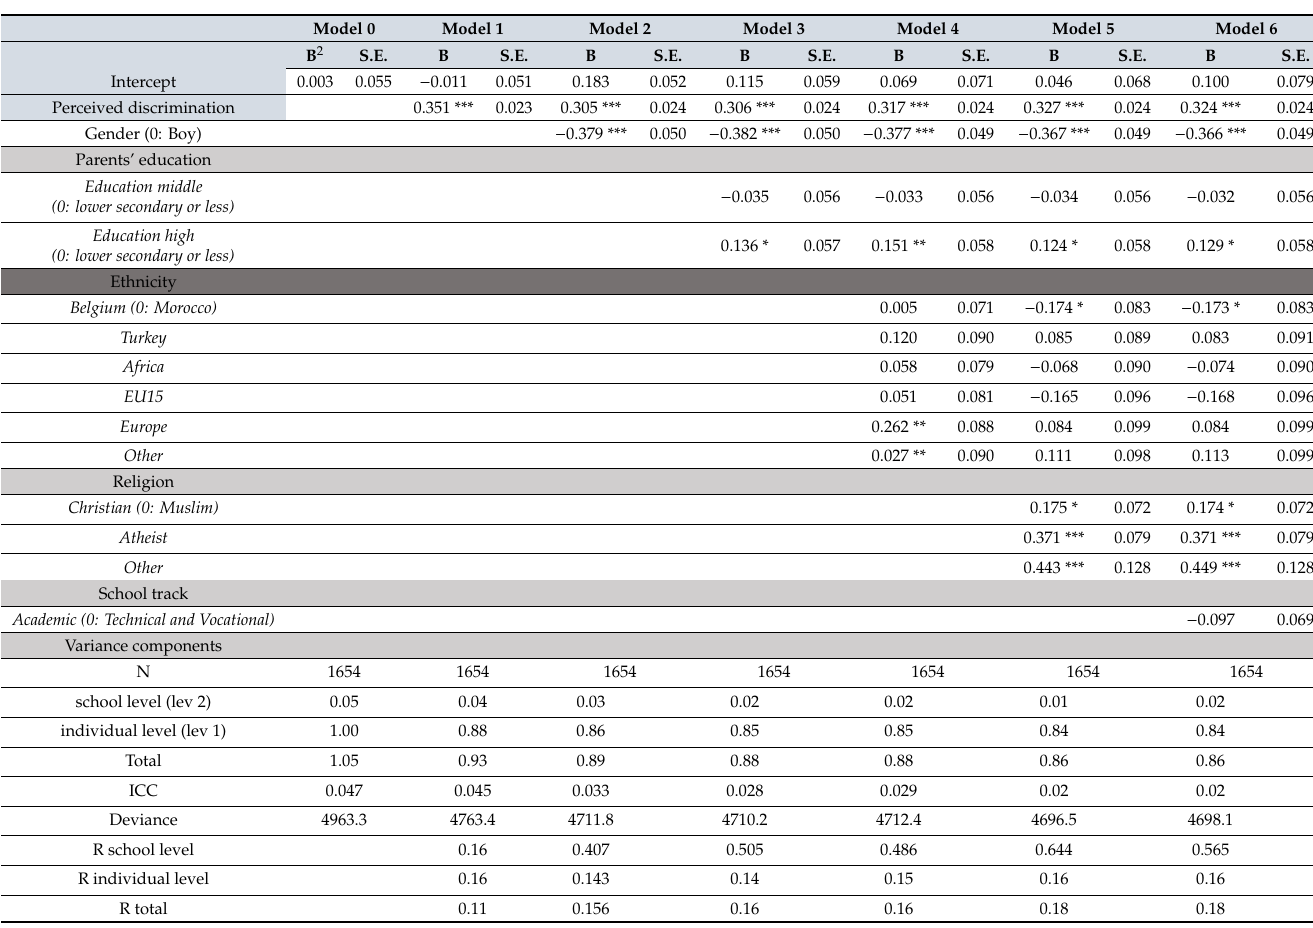
Table 5. Multilevel regression model concerning perceived discrimination and willingness to use violence among 10th graders in Brussels (N: